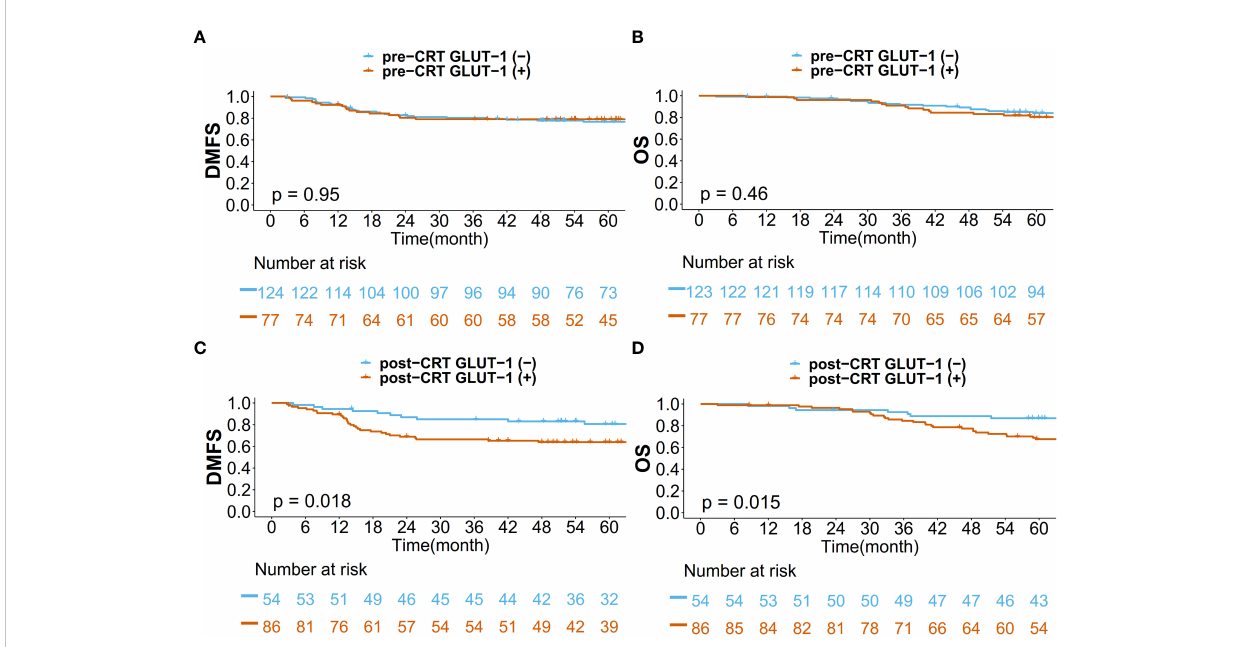
FIGURE 3 Kaplan – Meier curves for (A) DMFS based on pre-CRT status, (B) OS based on pre-CRT status, (C) DMFS based on post-CRT status, and (D) OS based on post-CRT